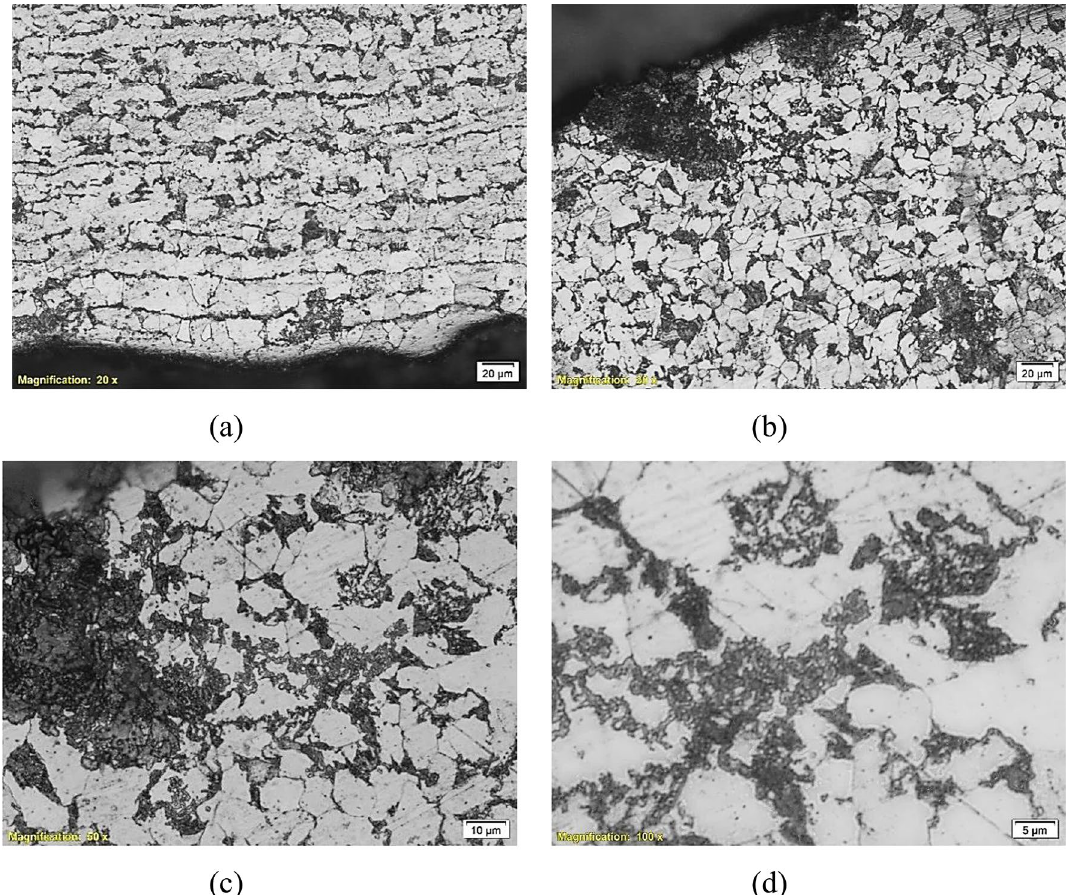
Figure 11. Microstructure of the failed elbow UB1-B2: ( a ) cross-section at internal surface showing typical carbon steel microstructure, ( b , c ) cross-section at external corroded surface, showing corrosion pits and subsurface reaction products, and ( d ) a higher magnification micrograph showing an early stage of pearlite decomposition and carbide spheroidization. This is also seen in ( a ) and the internal surface.